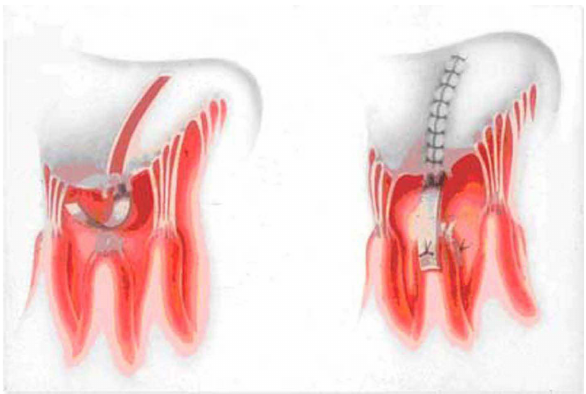
Fig 2 – Left: the strip of tissue is tucked through the slit under the edge of the leaflet. Right: the opening in the prior leaflet is repaired with interrupted 5-0 polypropylene suture, and the neo chorda is sutured to the anterior papillary muscle with 5-0 mattress sutures